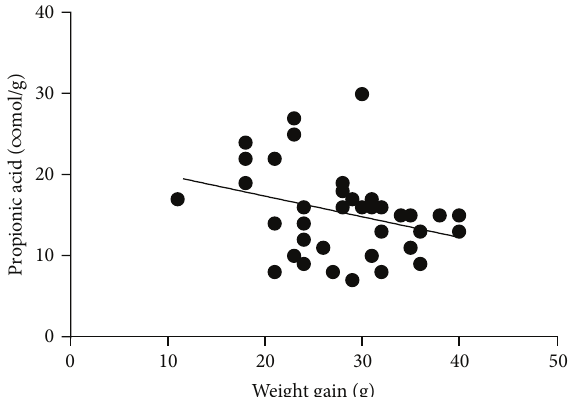
Figure 1: The level of propionic acid decreased with weight gain ( 𝑃 < 0.05 , correlation factor − 0.317).